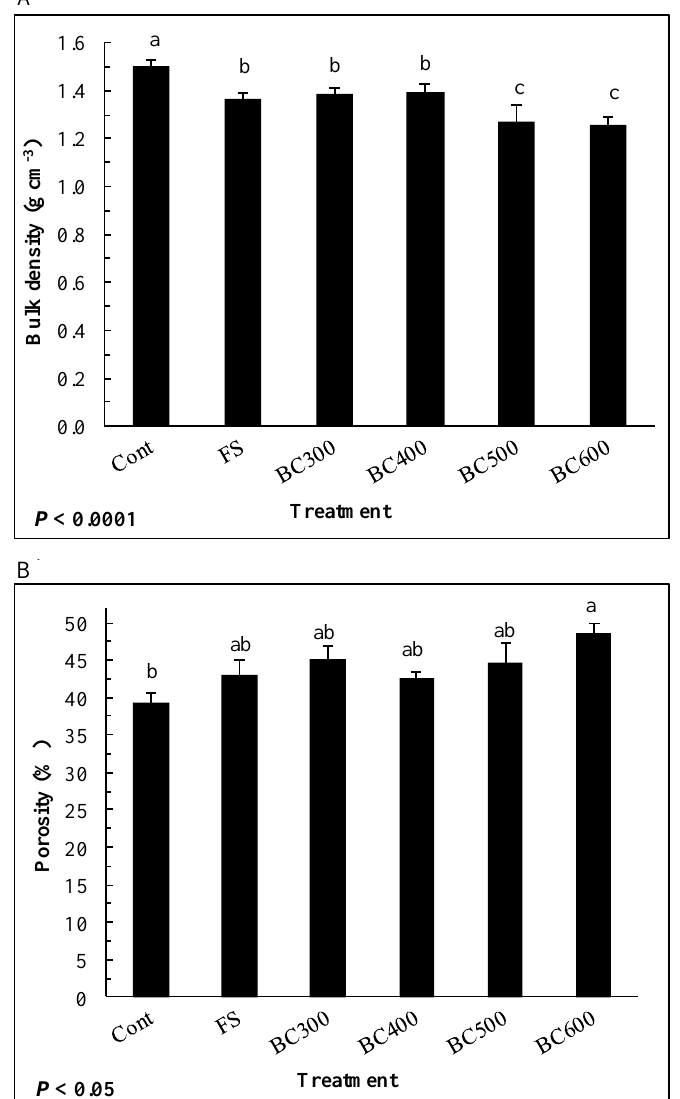
Figure 6. Effects of 8 t ha − 1 of four date palm residues BCs (BC300, BC400, BC500, and BC600) and the FS on soil bulk density ( A ) and total porosity ( B ) after eight months of incubation. Bars sharing the same letter among treatments are not significantly different according to the SNK test ( p ≤ 0.05). Errors bars represent the standard error of the mean ( n =4).